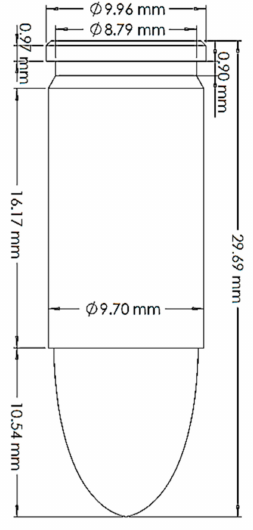
Figure 3. The geometry of the 9 mm FMJ RN